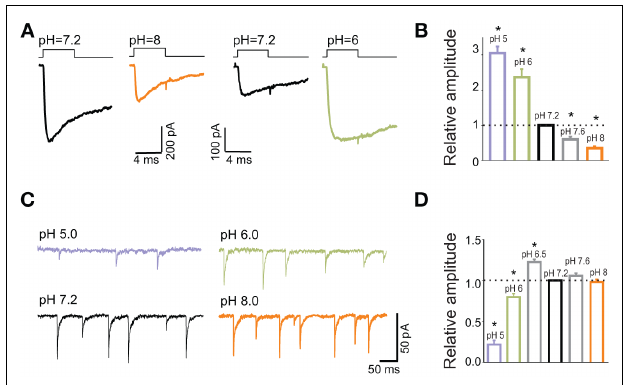
FIGURE 4 | Current responses to applications of saturating GABA concentrations show different pH-sensitivity than mIPSCs. (A) Typical current responses to applications of saturating (GABA) at pH = 7.2 black) and at pH = 8 (orange) and pH = 6 (green).Traces are presented in pairs (pH = 7.2, 8.0 and pH = 7.2, 6.0) that were recorded from the same excised patches. (B) Statistics of relative amplitudes (normalized to that measured at pH = 7.2). Note a strong and monotonic pH-dependence. (C) Typical traces of mIPSCs recorded at various pH values as indicated. (D) pH-dependence of mIPSC amplitudes. Note a qualitatively different proton effect in comparison to that observed for current responses (B) . Modified from Mozrzymas et al. (2003b) with permission.